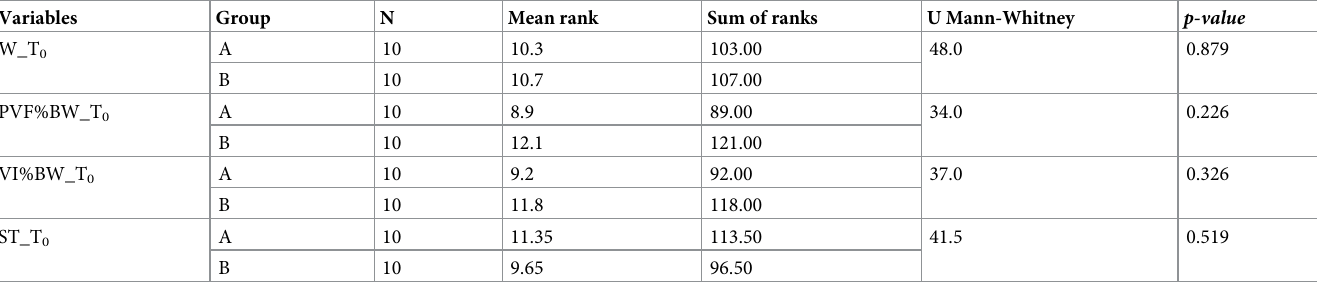
Table 2. Body-weight and GFRs at time T 0 : Ranks and Mann–Whitney U-test values. Variables